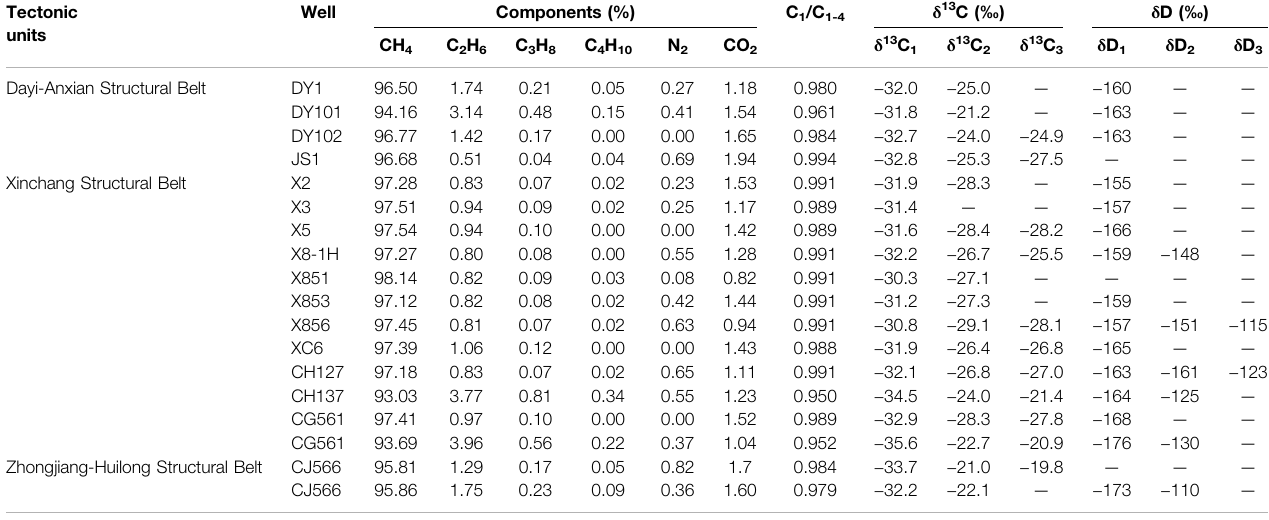
TABLE 1 | Main components and stable carbon and hydrogen isotopic compositions of the T 3 x 2 tight gas from the Western Sichuan Depression. Tectonic Well units